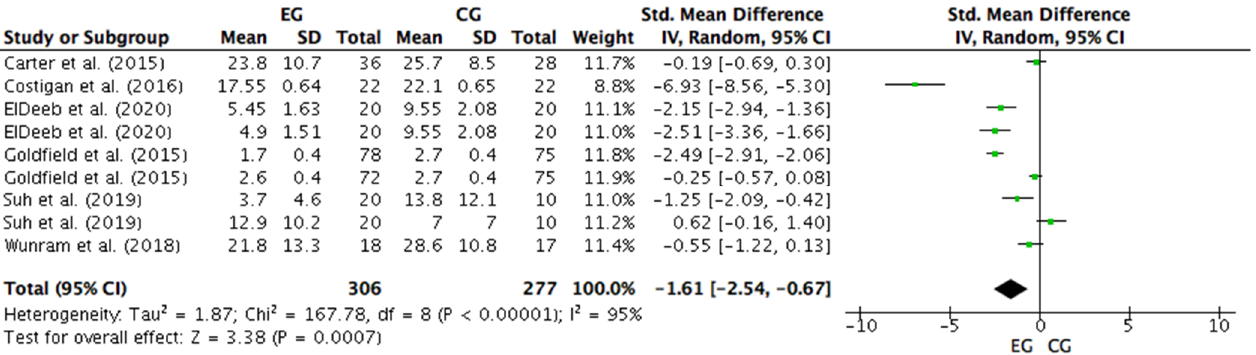
Figure 7. Forest plot comparing the effects of concurrent training on depression levels. EG: experimental group; CG: con- trol group; SD: standard deviations.